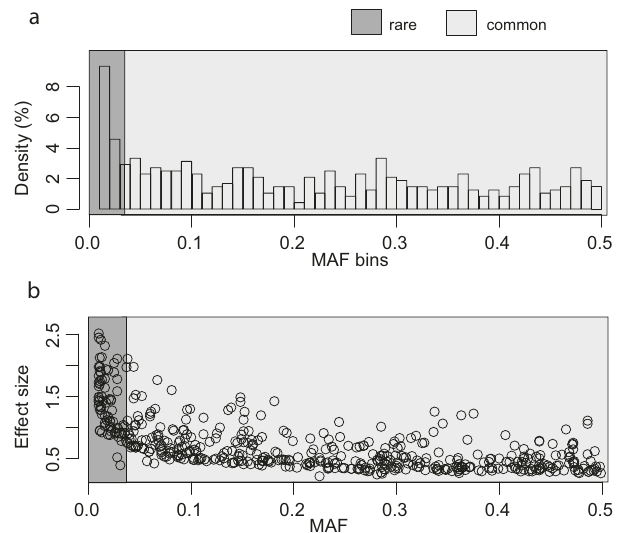
Fig. 2 MAFs and effect sizes for the lead GWAS SNVs and indels. a Distribution of MAFs for the lead GWAS-signi fi cant (Wald-test, p < 5.00 × 10 – 8 ) primary and conditional hits. A MAF threshold of 0.01 was used in the GWAS and, consequently, no GWAS hits had a MAF below 0.01. b Effect sizes from the GWAS, in relation to MAF for the primary and conditional GWAS hits. All effect estimates are reported as absolute